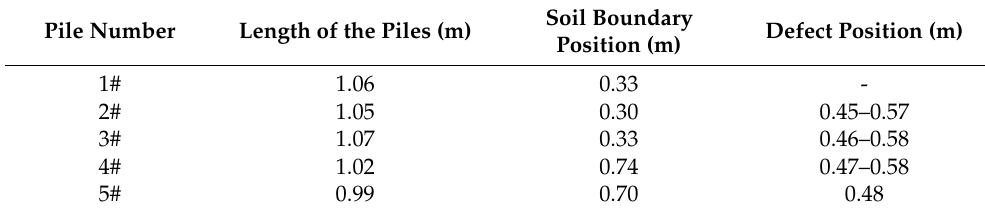
Table 3. Simulation results of pile dynamic